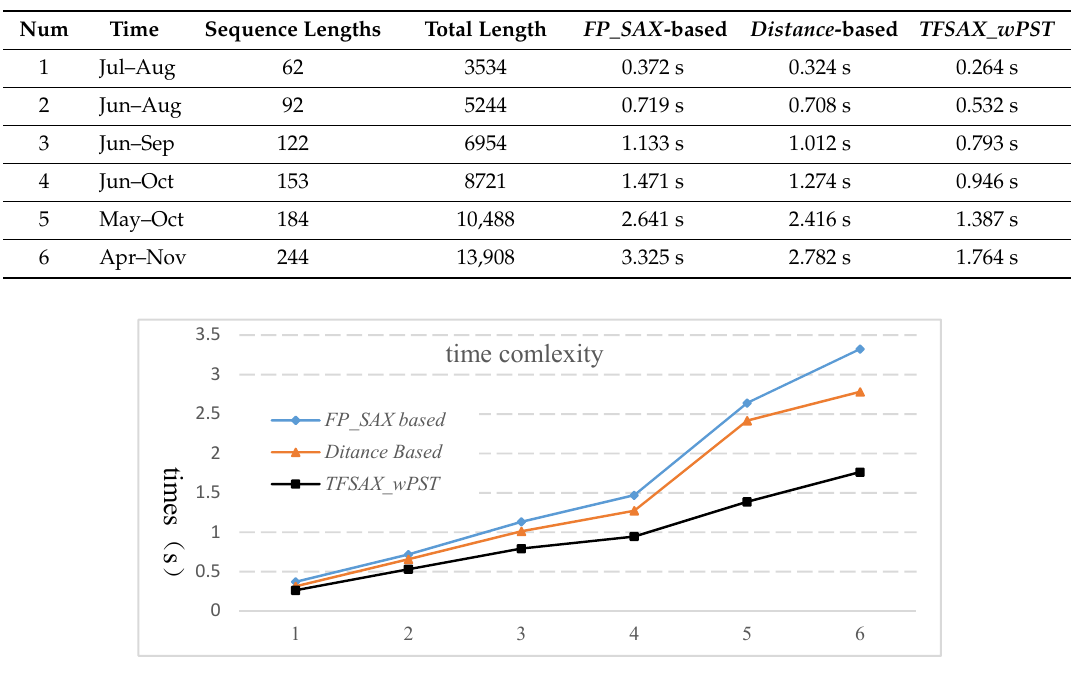
Figure 11. A comparison of the runtime of di ff erent